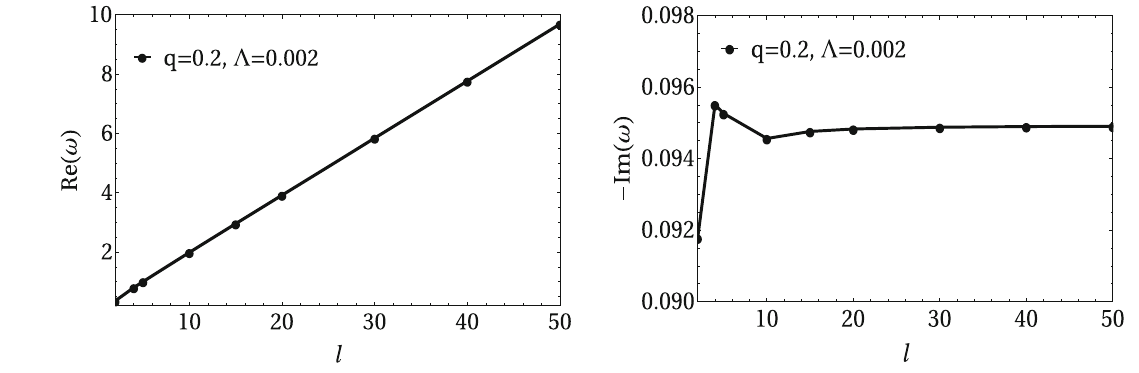
Fig. 7 Variation of Re ω and -Im ω with multipole number (cid:12) for (cid:2) = 0 . 002 and n =